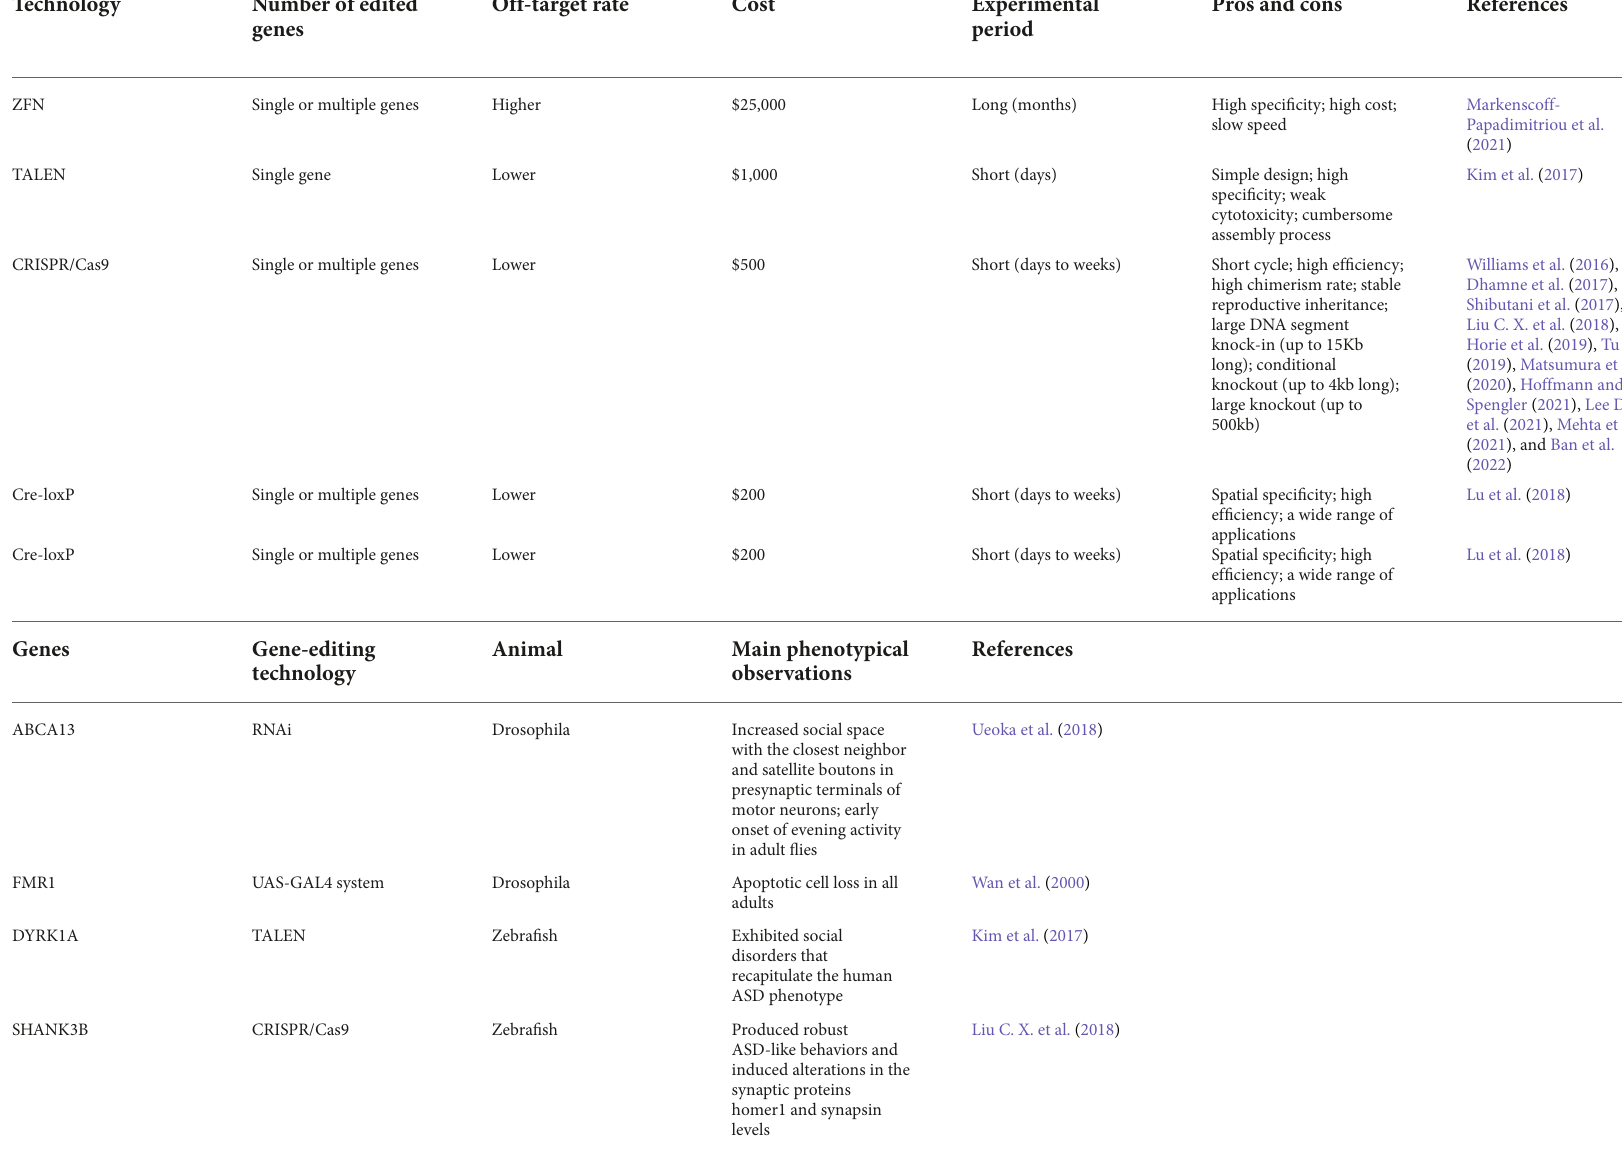
TABLE 1 Pros and cons of different gene editing techniques, and monogenic ASD animal models established by gene